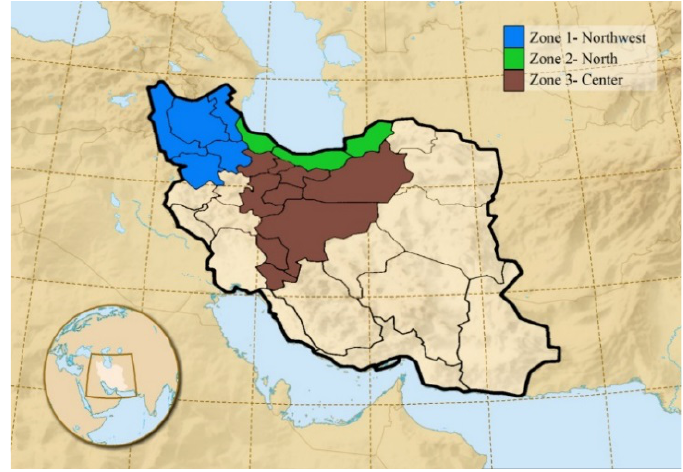
Figure 1. Classification of three study zones according to climate conditions in Iran